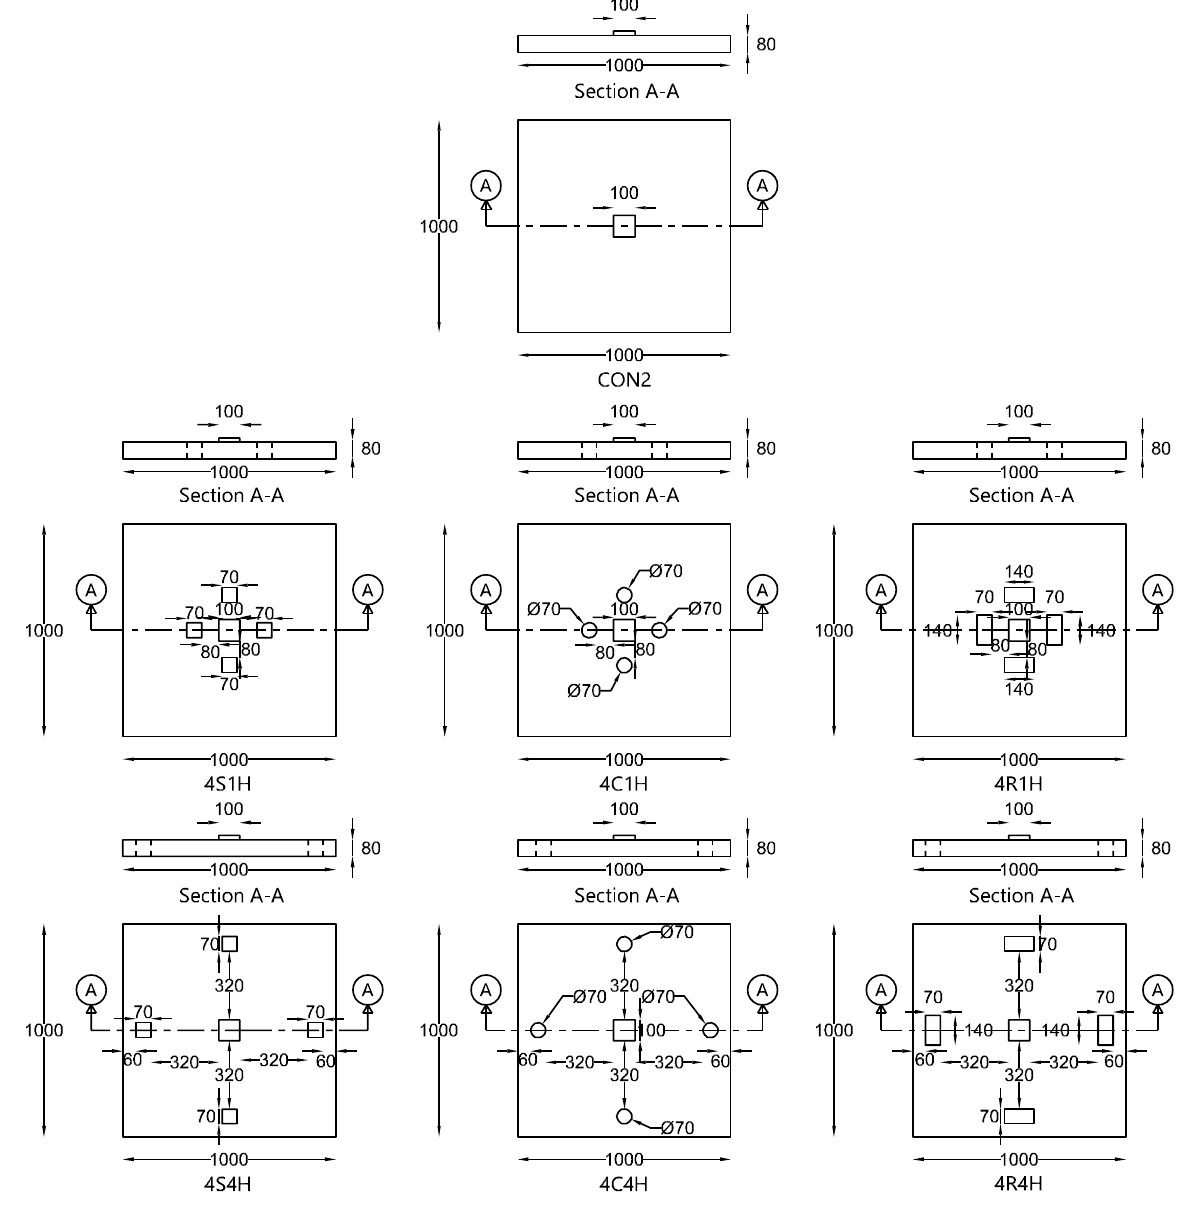
Figure 2. Layout of specimens with 4 openings (units: mm).